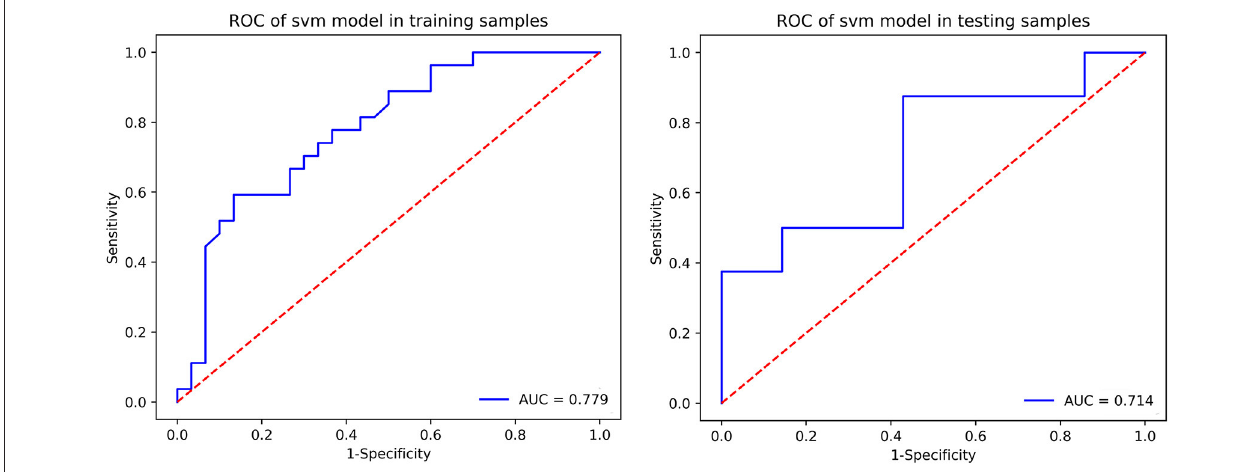
FIGURE 2 | ROC of the SVM model in the training and testing